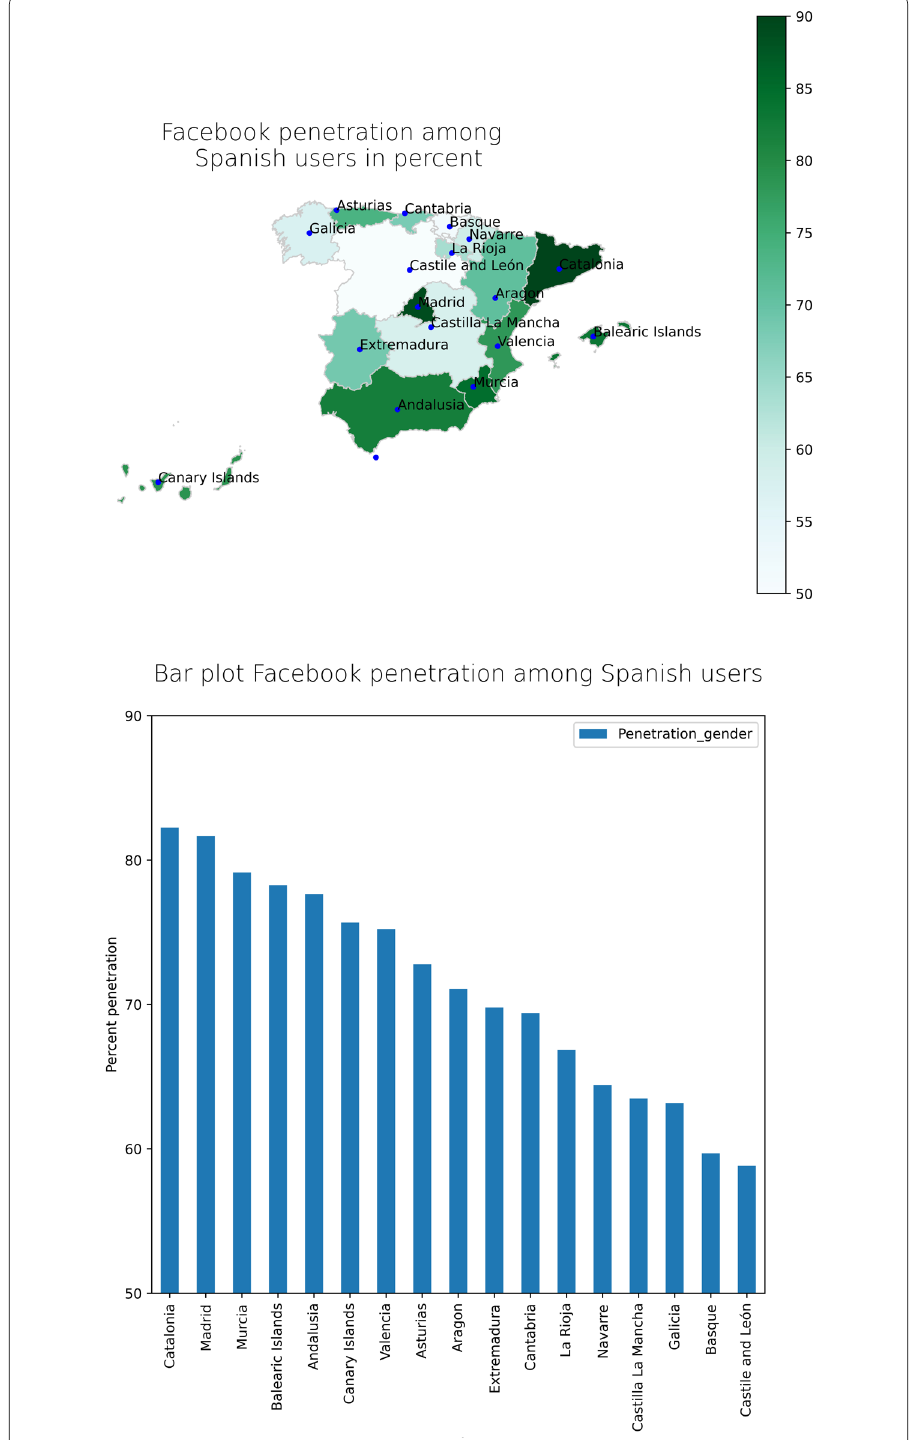
Figure 1 Facebook penetration in